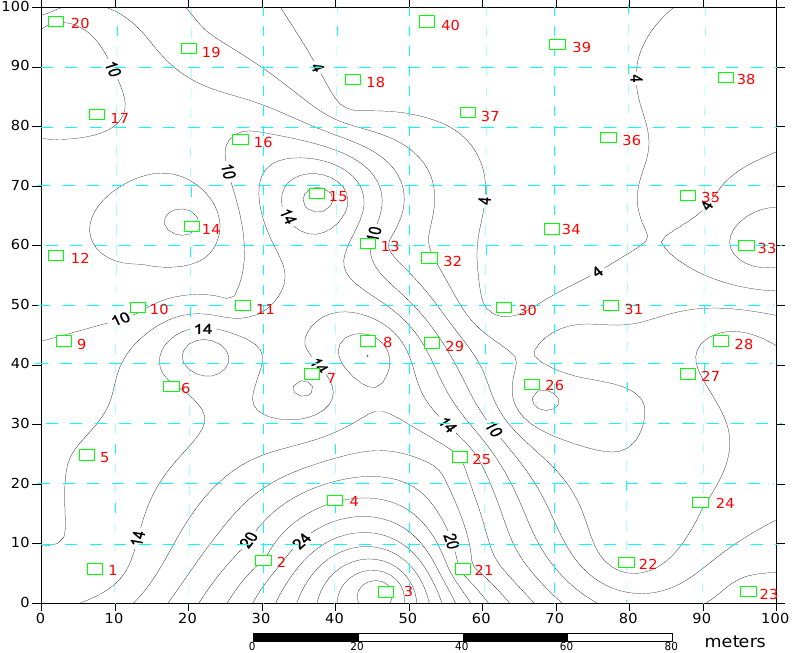
Figure 1. Distribution of measuring points and ground elevation in the experiment site. The numbers in red indicate the randomly selected sampling points. The unit of ground elevation is